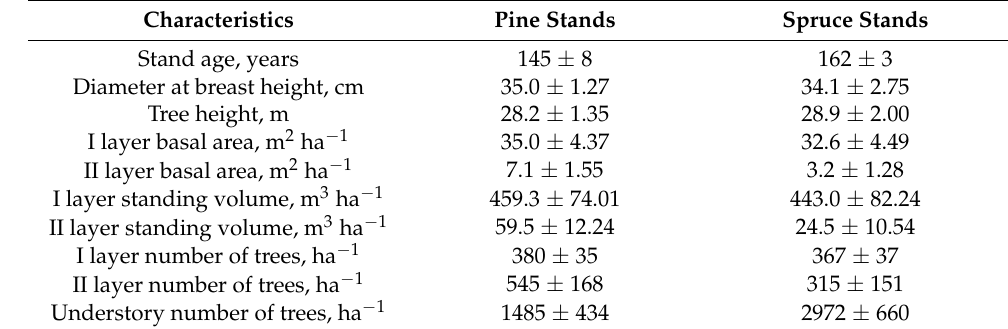
Table 2. Characteristics (mean ± 95% confidence interval) of old-growth Scots pine-dominated and Norway spruce-dominated stands in Myrtillosa turf.mel . forest type. Characteristics Pine Stands Spruce Stands Stand age, years 145 ± 8 162 ±